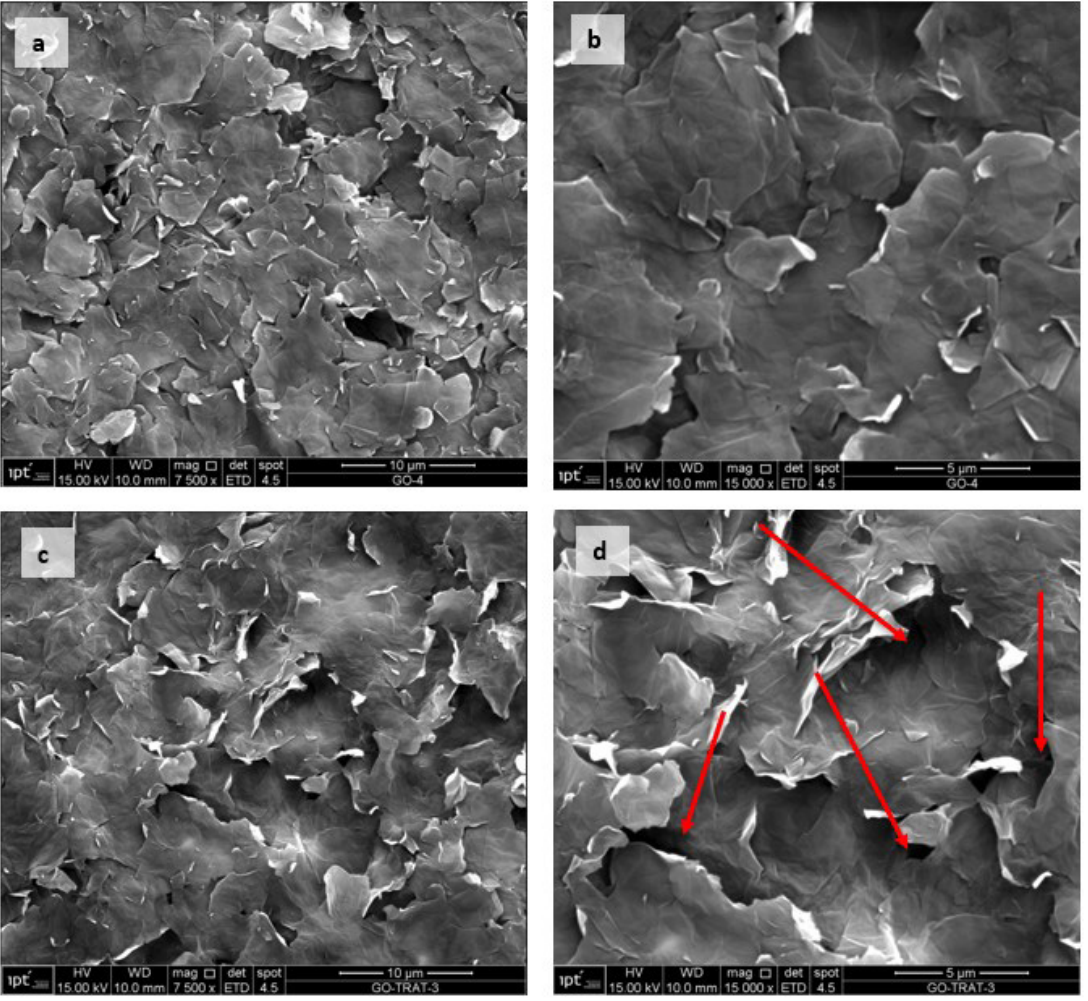
Figure 4. Pure GO paper-like SEM images untreated ( a-b ) and treated ( c-d ) thermally. Red arrows in ( d ) indicate gas voids regions caused by thermal